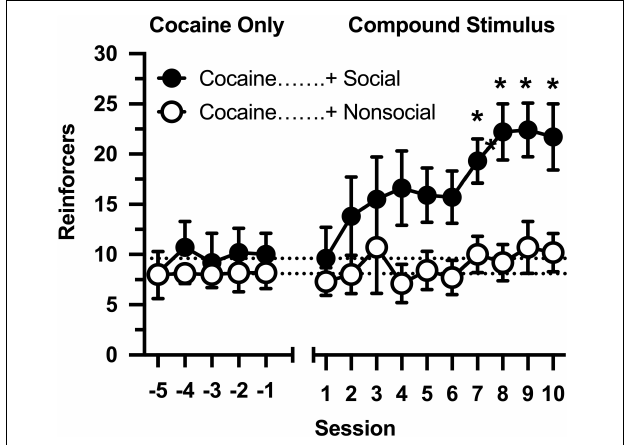
FIGURE 1 | Number of reinforcers obtained during daily, 60-min test sessions. Data reflect the mean (SEM) number of cocaine infusions from rats assigned to the social (“+ Social,” filled symbols; n = 12) and non-social (“+ Non-social,” open symbols; n = 9) groups. For the first five sessions (Sessions –5 to –1), responding was maintained only by cocaine (0.5 mg/kg). For the following 10 sessions (Sessions 1 to 10), responding was maintained by cocaine and 30-s access to either a social (sex- and age-matched partner) or non-social (black-and-white athletic sock) stimulus. Dashed lines originating at the X-intercept reflect the average number of cocaine infusions during the first five sessions (social: 9.6 infusions; non-social: 8.1 infusions). Asterisks indicated significant differences between social and non-social groups.